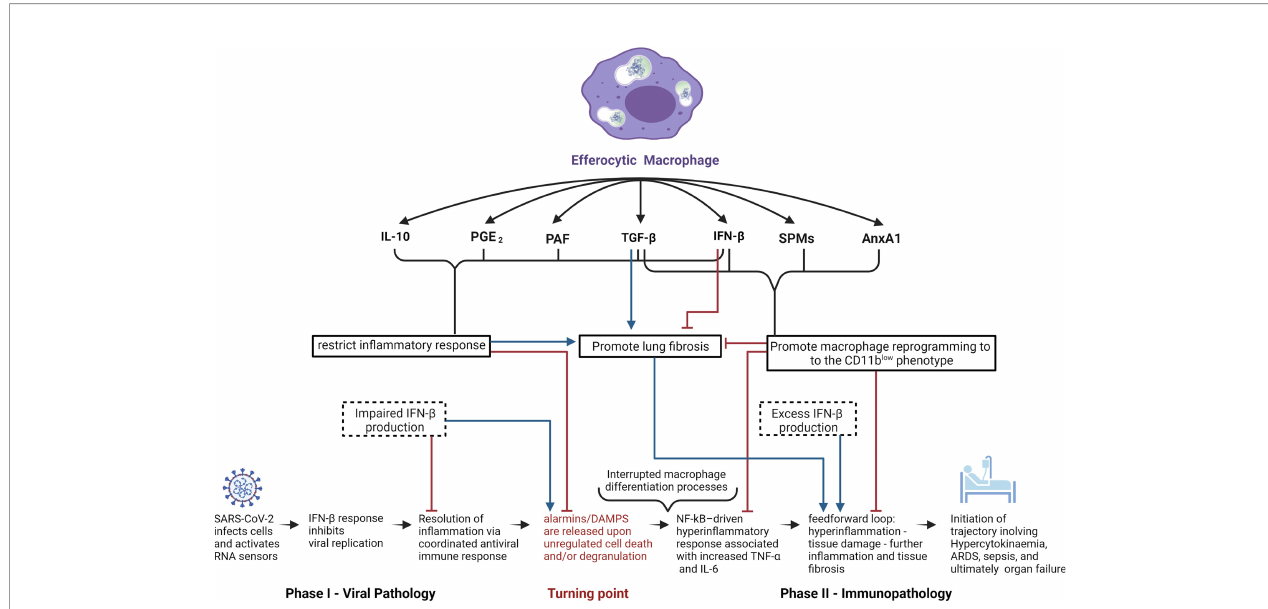
FIGURE 2 | Potential role of efferocytic macrophages in COVID-19 pathogenesis. Schematic representation of potential mechanisms by which efferocytic macrophage-produced mediators could affect COVID-19 pathogenesis. Anti-in fl ammatory effectors IL-10, PGE 2 , and PAF all restrict the in fl ammatory response which, while crucial for inhibiting the progression of viral infection and immunopathology, have the potential to promote fi brosis. SPMs and AnxA1 can inhibit fi brosis by promoting macrophage reprogramming towards the CD11b low phenotype, parallel with inhibition of the feedforward hyperin fl ammatory loop. The cytokines TGF- b and IFN- b (at low concentrations and when temporally restricted) have the ability to inhibit fi brosis, due to their ability to restrict the in fl ammatory response as well as to promote macrophage reprogramming to the CD11b low phenotype. On the other hand, chronic exposure to high doses of TGF- b or IFN- b may result in pathologic fi brosis or autoin fl ammatory disorders. In the light of IFN- b ’ s anti-viral and anti-in fl ammatory properties, IFN- b de fi ciency during phase I of COVID-19 infection and excess IFN- b production during phase II can have deleterious consequences in disease progression and in fl ammation